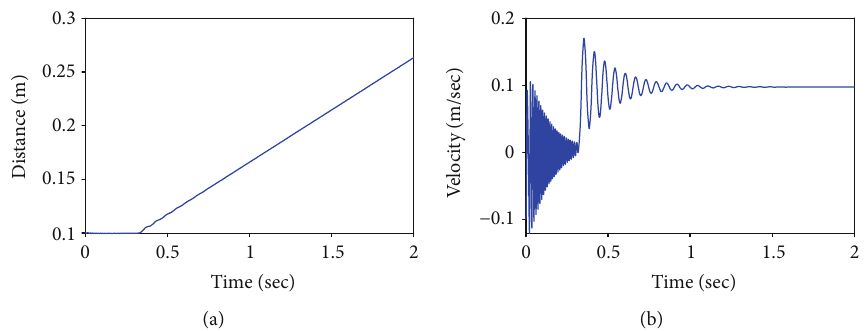
and S ; (b) relative velocity 1 2